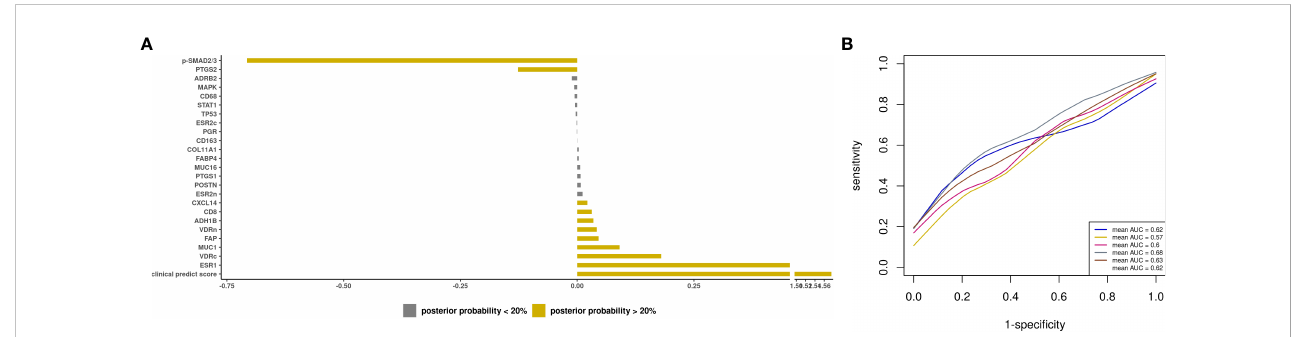
FIGURE 5 Prediction modeling of optimal debulking status using epidemiologic/clinical predictors and tissue markers. Average posterior means and associated average posterior probabilities of epidemiologic/clinical predictors and tissue markers being selected in the fi nal prediction model of optimal debulking status and area under the curve (AUC) of the prediction models using Bayesian model averaging among invasive epithelial ovarian cancer cases (n=166) in NHS/NHSII/NEC. We assessed the posterior probability of 24 tissue markers in addition to our base model of clinical predict score, which included epidemiologic/clinical variables that had ≥ 20% posterior probability of being selected in the fi nal prediction model of optimal debulking status (i.e. aspirin, parity, and menopausal status), for possible selection in the fi nal model and conducted fi ve 5-fold cross-validations. The bar chart (A) presents the average posterior mean across the 25 models that were run in total; grey bars denote predictors with average posterior probabilities <20% and yellow bars denote predictors with average posterior probability ≥ 20%. (B) presents the fi ve average AUCs from the fi ve 5-fold cross-validations and in the legend overall AUC, which is the average of the average AUCs from the 5-fold CV, is